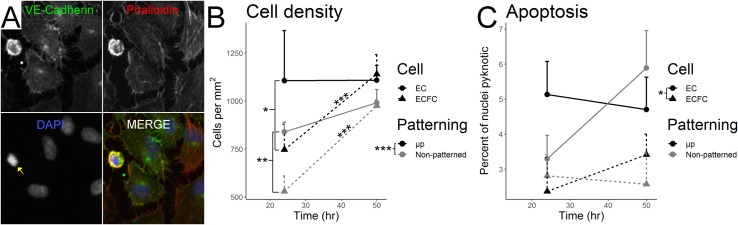
Micropatterning significantly increases cell density.EC apoptotic rate is higher than ECFC, regardless of micropatterning. Stained EC and ECFC nuclei were counted in order to quantify cell density and apoptotic rate. (A) Representative micrograph of a pyknotic nucleus (yellow arrow, DAPI channel) surrounded by healthy cells in a non-patterned EC sample after 50 hours of culture. (B) Micropatterning significantly increases cell density across other culture conditions (p = 0.0002). Post-hoc testing showed significantly greater EC than ECFC density at 24 hours in both non-patterned (p = 0.0024) and micropatterned cells (p = 0.011), however no significant cell-type differences existed after 50 hours (p = 1, both). As noted by stars above trend lines, ECFC density significantly increased between 24 and 50 hours of culture time in both non-patterned (p = 0.0009) and micropatterned (p = 0.0002) cultures, while EC density did not (p = 1 non-patterned, p = 0.689 μp). (C) ECs showed a significantly greater rate of apoptosis than ECFCs across culture conditions (p = 0.0151), however micropatterning (p = 0.732) and culture time (p = 0.336) had no significant effects on apoptotic rate.